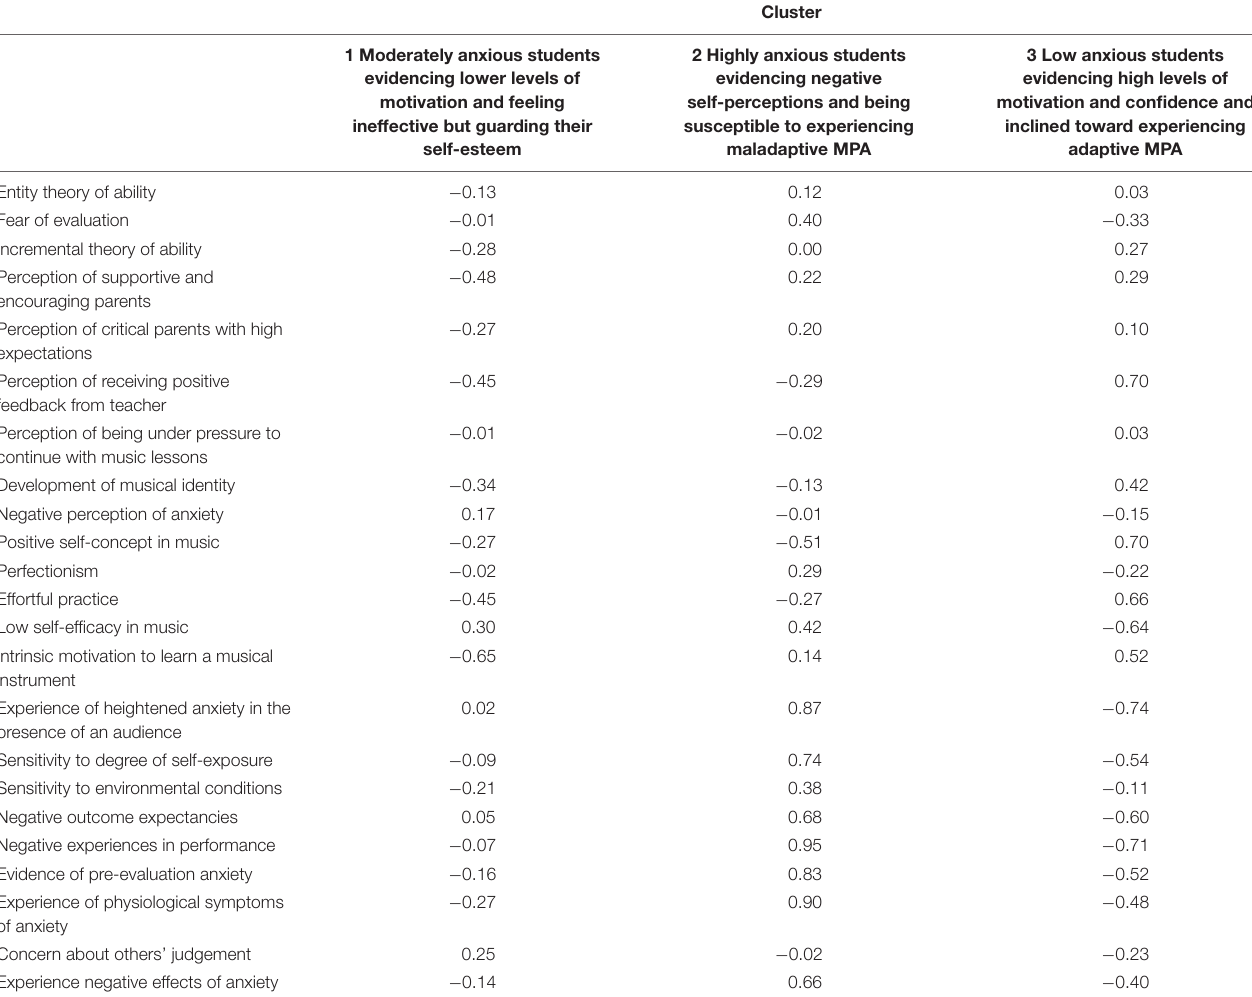
TABLE 3 | Final cluster centre mean values for each variable included in the analysis.